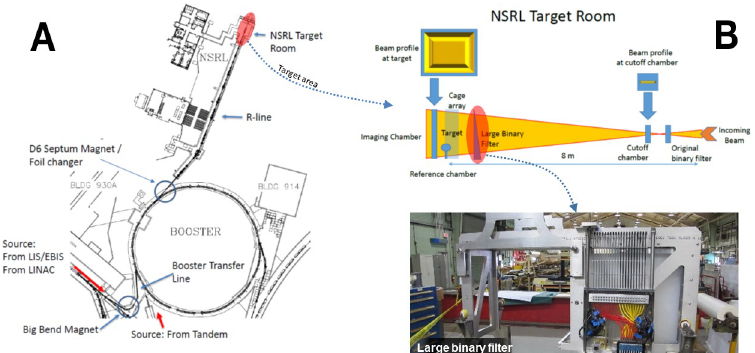
Fig 11. Facility layout of NSRL at BNL. (A) Tools to reliably control system hardware settings, from ion production by the LIS through booster injection, acceleration, extraction, and delivery to the NSRL target room were developed to sequentially deliver the GCR simulator ion-energy beam combinations. (B) Position of imaging chamber behind target (top, left-hand side), cut-off chamber (top, right-hand side) near beam entrance to target room, and photo of large- area degrader (binary filter) system (bottom) in NSRL beam line to maintain control and uniformity of 60 × 60 cm 2 beam. BNL, Brookhaven National Laboratory; EBIS, Electron Beam Ion Source; GCR, galactic cosmic radiation; LINAC, Linear Accelerator; LIS, laser ion source; NSRL, NASA Space Radiation